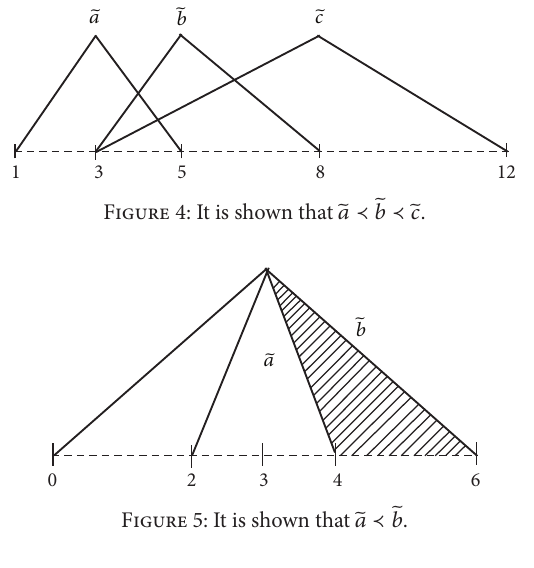
Figure 6: It is shown that